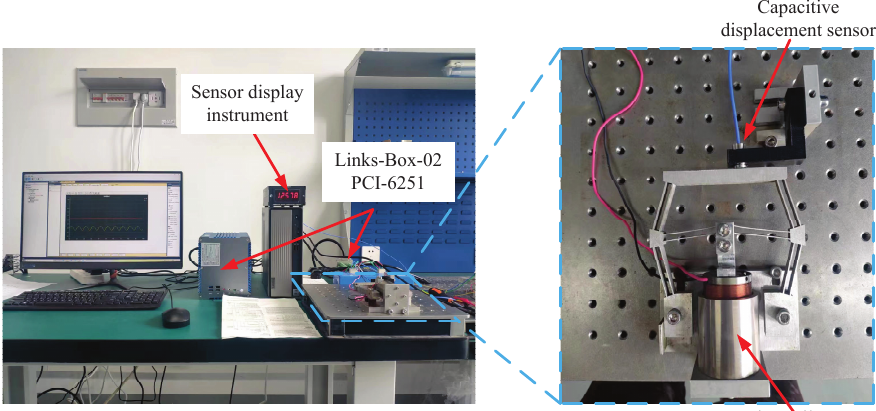
Figure 14. Experimental setup for position control.